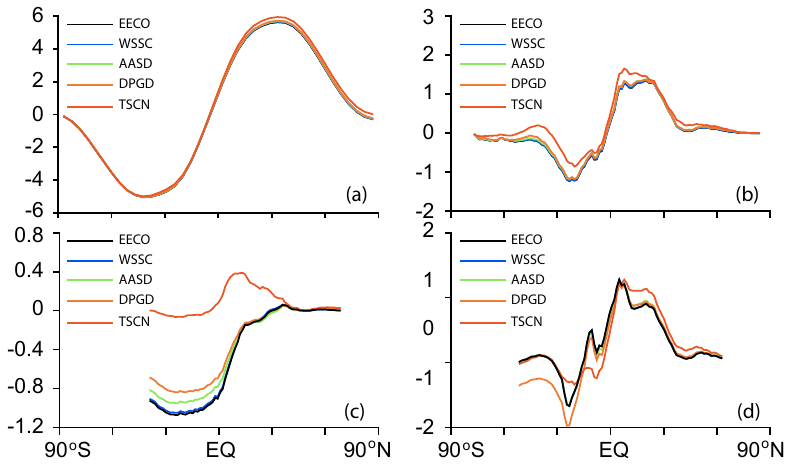
Figure 5: Heat transports in the EECO (black), WSSC (blue), AASD (green), DPGD (orange) Fig. 5. Heat transports in the EECO (black), WSSC (blue), AASD (green), DPGD (orange) and TSCN (red), (a) total heat transport, (b) and TSCN (red), (a) total heat transport, (b) ocean heat transport for all ocean basins, (c) ocean heat transport for all ocean basins, (c) Atlantic heat transport, (d) Pacific heat transport. Atlantic heat transport, (d) Pacific heat transport.